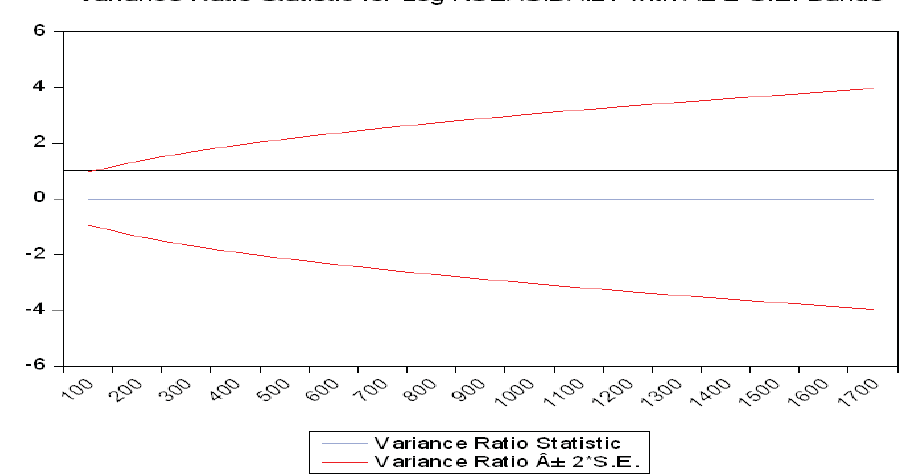
Fig. 3. Graphical illustration of the efficiency of the NSE ASI (daily data over the test periods: February 2008 to January 2015) (cid:3)